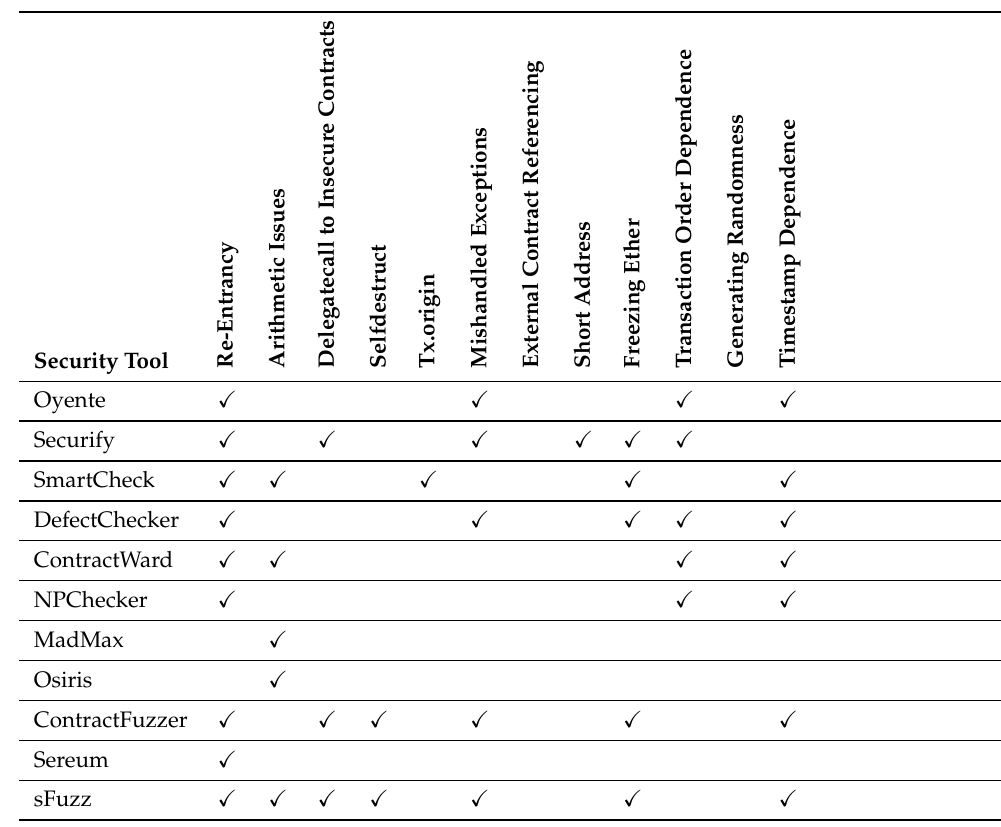
Table 3. Tools and vulnerabilities